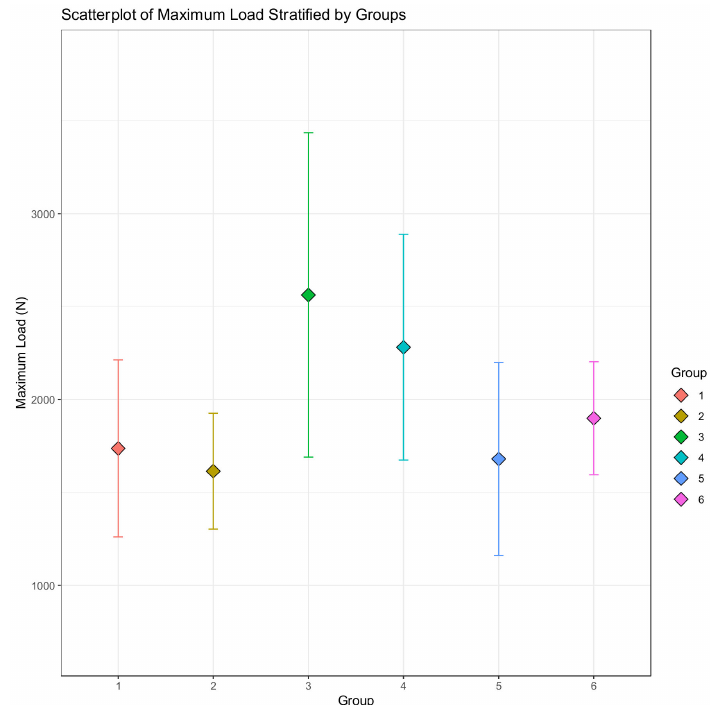
Figure 7. Scatterplot depicting the distributions of data for the maximum load measured in Newtons. Diamonds indicate the means and error bars represent one standard deviation. Visual inspection suggests non-normally distributed